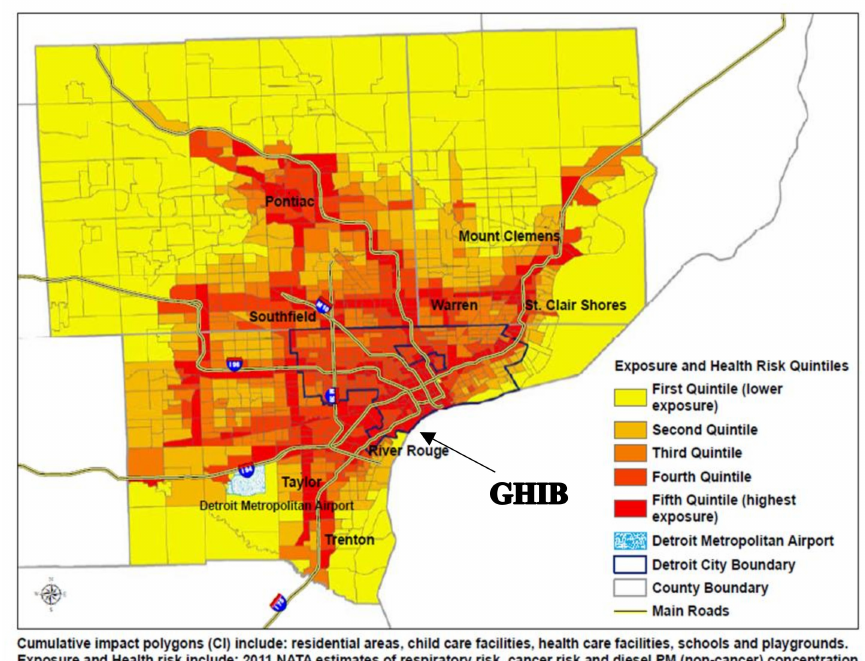
Figure 2. Diesel particulate matter exposure, cancer and respiratory risk attributable to air pollution in the Detroit Metropolitan Area